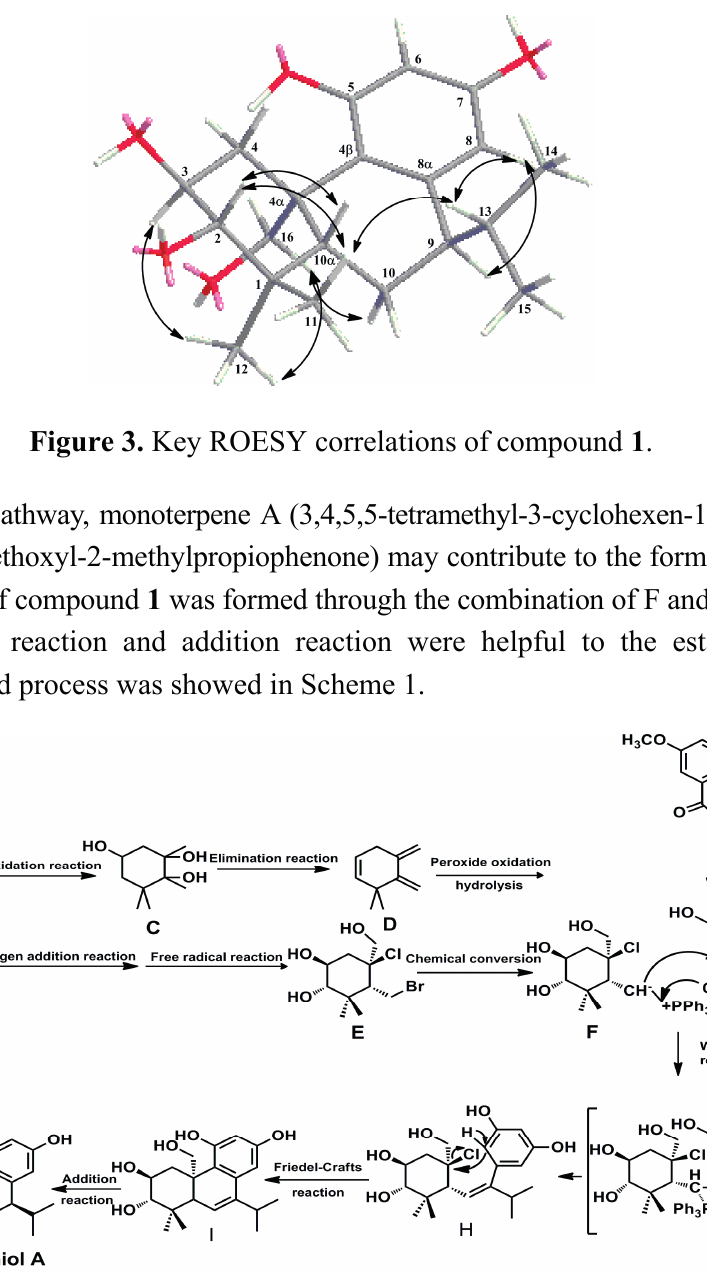
Figure 2. Key HMBC correlations of compound 1 (arrows points from H to C).